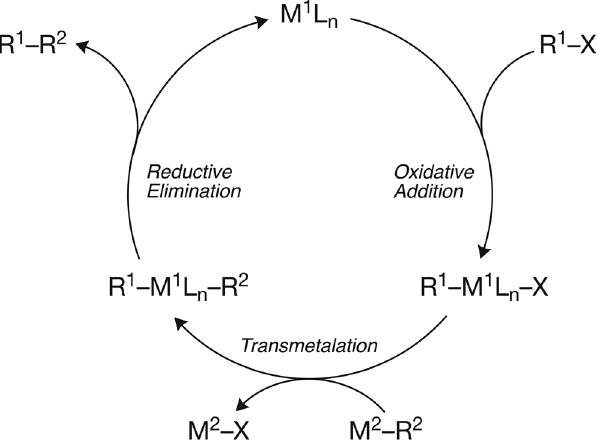
Figure 1. Generic catalytic cycle of a transition-metal-catalyzed cross-coupling reaction.